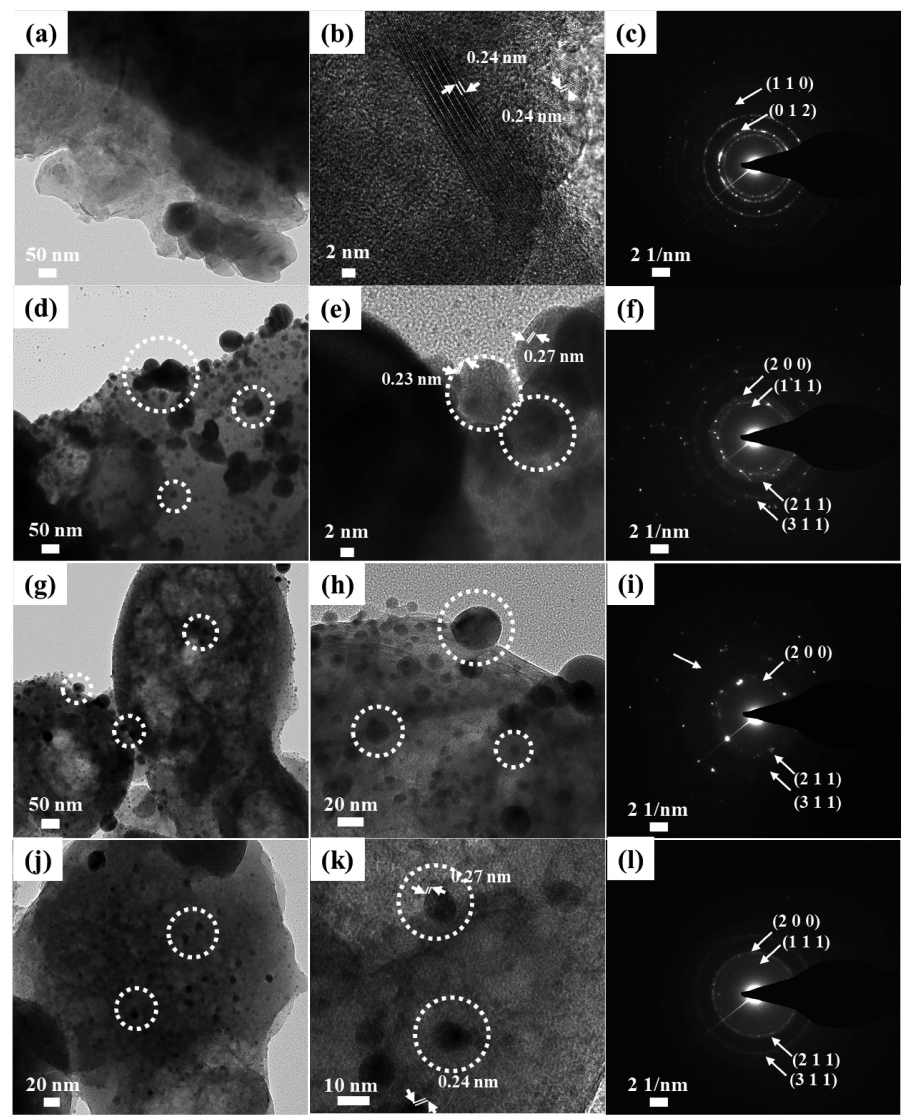
Figure 3. Transmission electron micrographs, higher magnification transmission electron micrograph (100,000 × ) with lattice fringes and selected area electron diffraction (SAED) patterns of pristine ( a – c ) MgAl–citrate LDH, ( d – f ) SONP@LDH-1, ( g – i ) SONP@LDH-1/3, and ( j – l ) SONP@LDH-1/10. Dotted circles stand for the